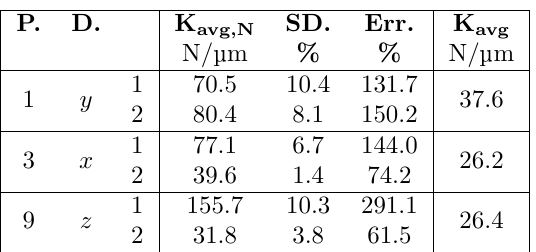
Table 5: 3-axis CNC, test 1.1: average stiffness at measurements point 1 and 2 and total stiff- ness. At different positions (P.) and direc- tions (D.). Dial indicator: Second, are the results that were ob-